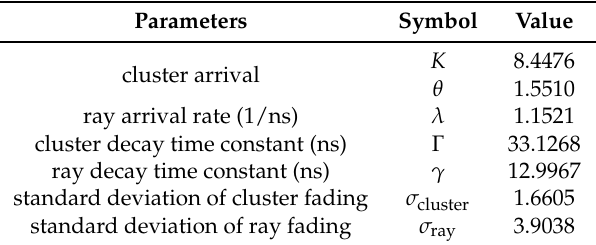
Table 2. Fading parameters for the cluster model. The inter-arrival times of rays and clusters are modeled using exponential and gamma densities, respectively. The path strength follows lognormal